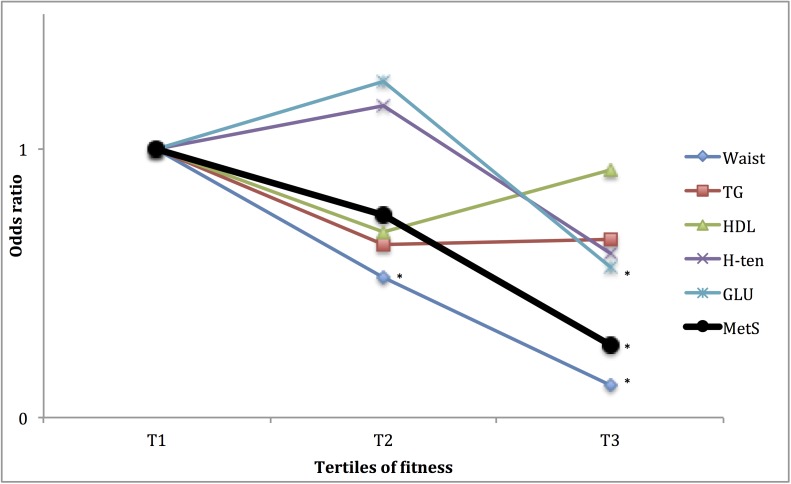
Relationship between tertiles of fitness and having unfavourable levels of sub-components of METs.ORs are adjusted for gender, age, education level (university degree vs. not), energy intake (kcal·d-1 in quartiles), smoking habits (regular smoker vs. not) and psycho-social stress (self-reported into four levels), % of wear time spent in SED and % of wear time spent in MVPA (in tertiles). * Denotes significant difference to reference group.